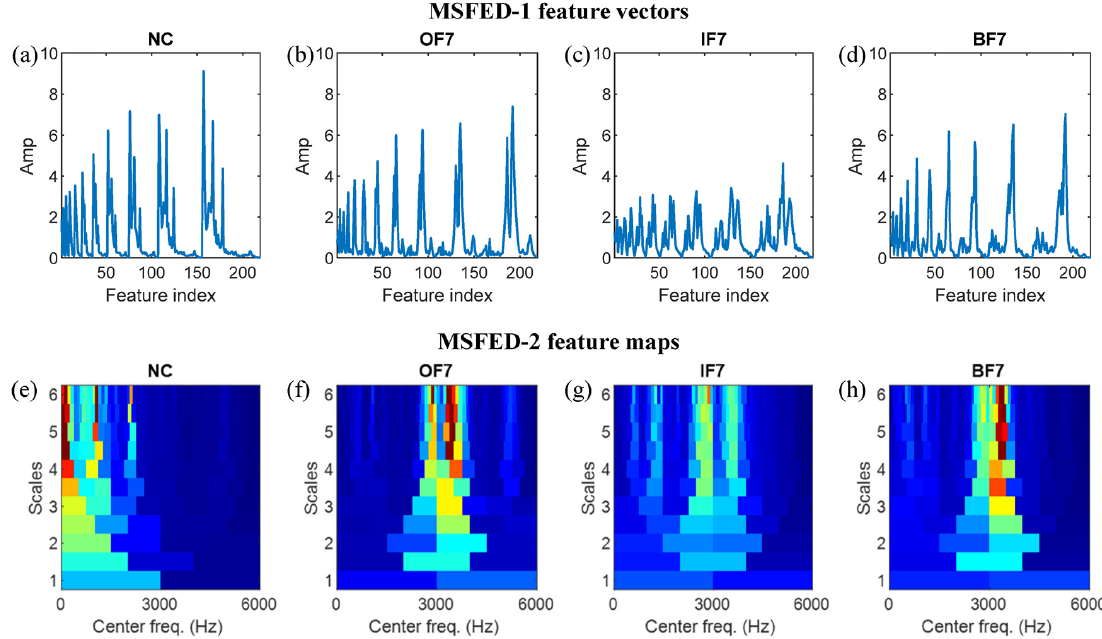
Figure 7. The MSFED-1 and MSFED-2 features of vibration samples at 1 hp: ( a – d ) MSFED-1 features of NC, OF7, IF7, and BF7 samples, ( e – h ), MSFED-2 features of NC, OF7, IF7, and BF7 samples.